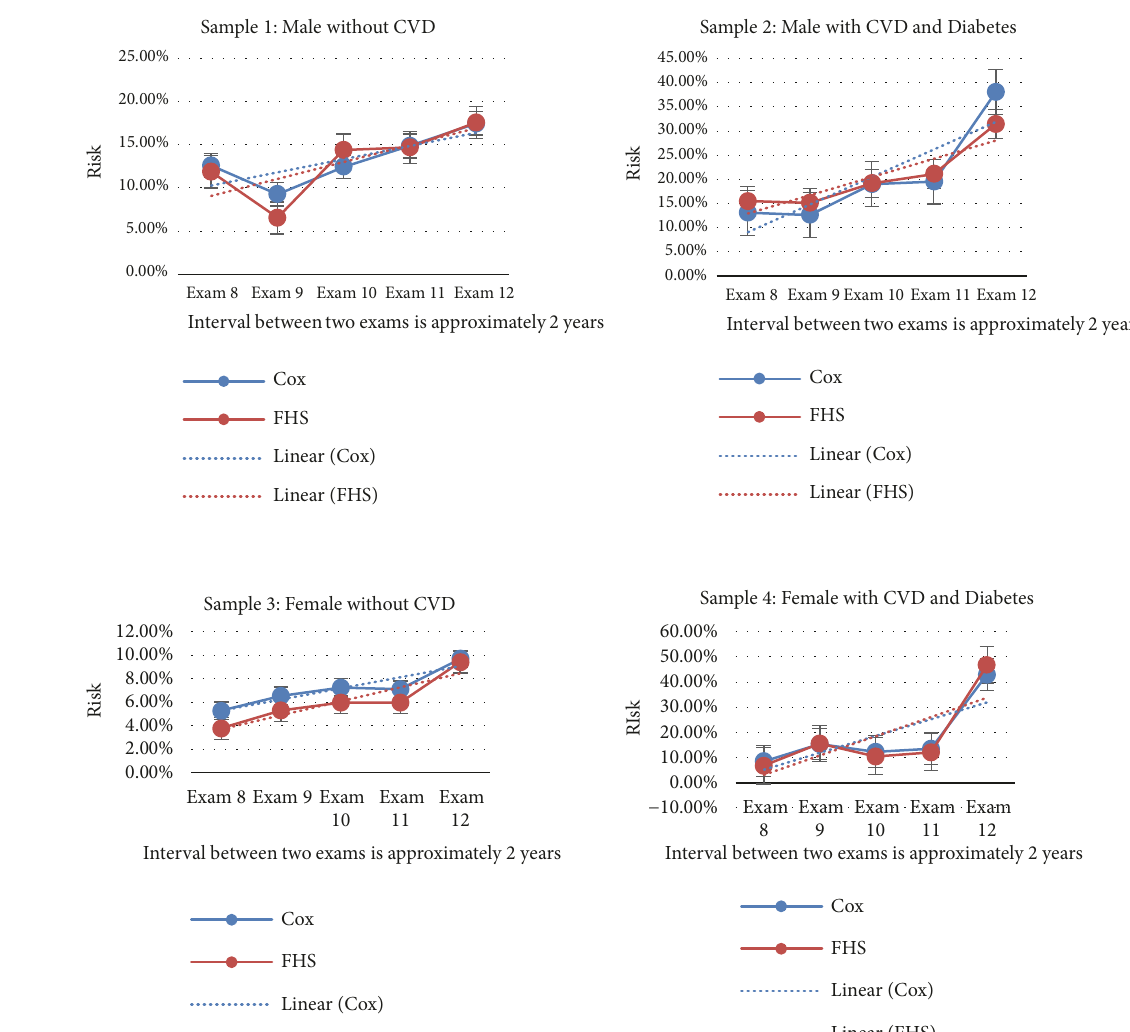
Figure 3: Longitudinal